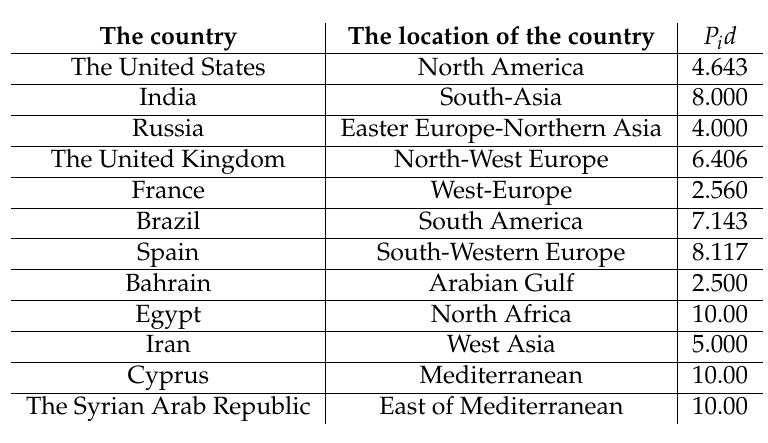
Table 1. The values of the incubation period of SARS-CoV-2 in the United States, Russia, the United Kingdom, India, France, Brazil, Spain, Bahrain, Egypt, Iran, Cyprus and the Syrian Arab Republic and the geographical location of each country.